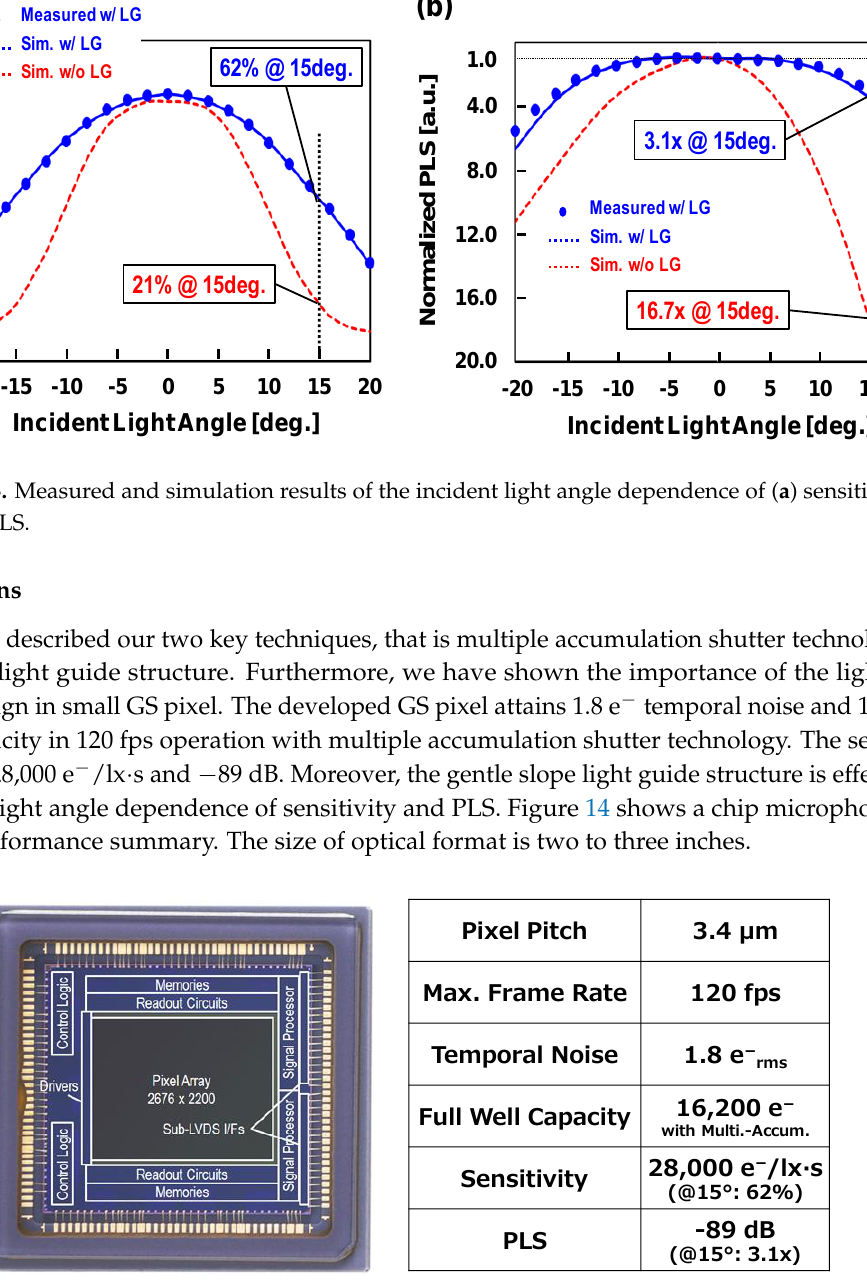
Figure 12. ( a ) Spectral sensitivity and ( b ) Spectral parasitic light sensitivity.